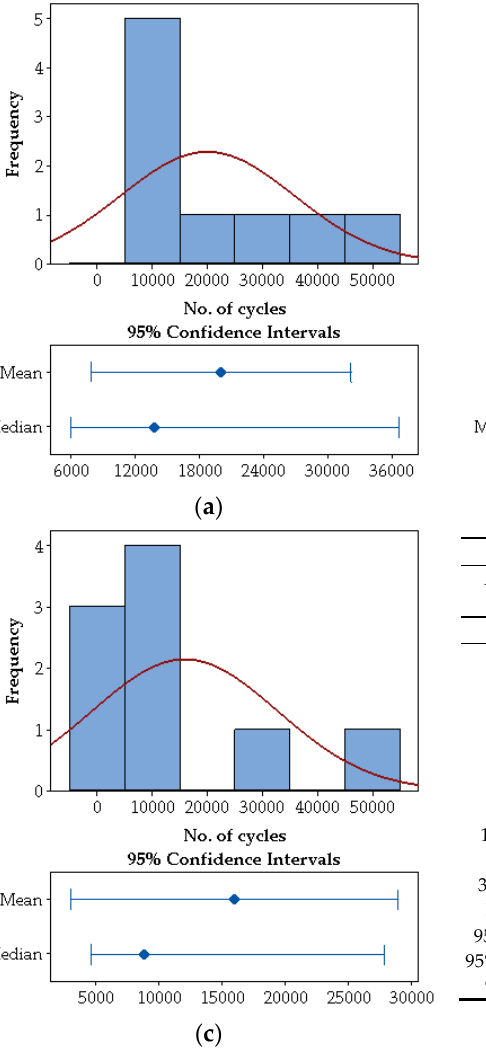
Figure 6. Histogram and confidence intervals: ( a ) REF; ( b ) SB1; ( c ) SB2; ( d ) and results of the normality test and summary statistics for the three groups of asphalt mixtures.